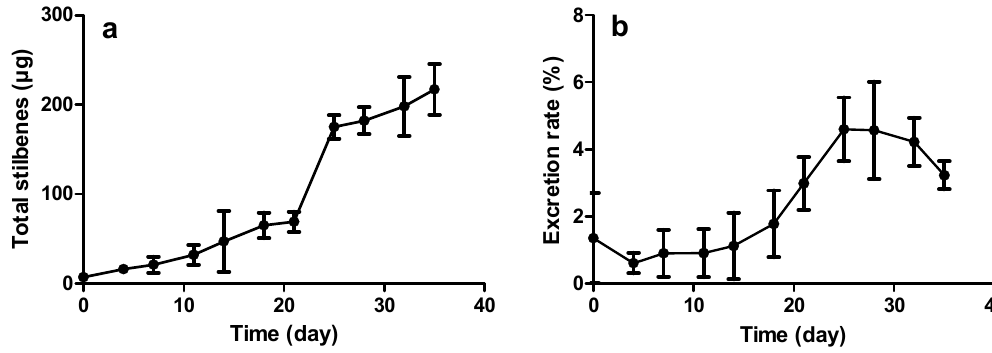
Figure 4. Stilbene production during growth kinetics: ( a ) total production of stilbenes (µg of stilbenes per culture flask); and ( b ) excreted stilbenes as a proportion of total stilbenes. Each point represents the mean with standard deviation of three biological replicates.